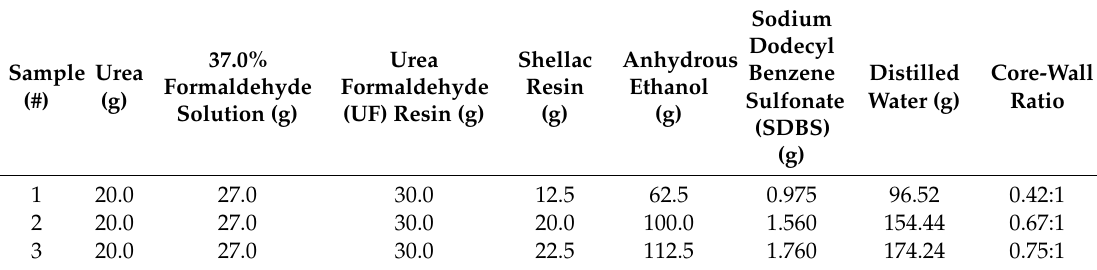
Table 1. The detailed list of each substance dosage for the fabrication of